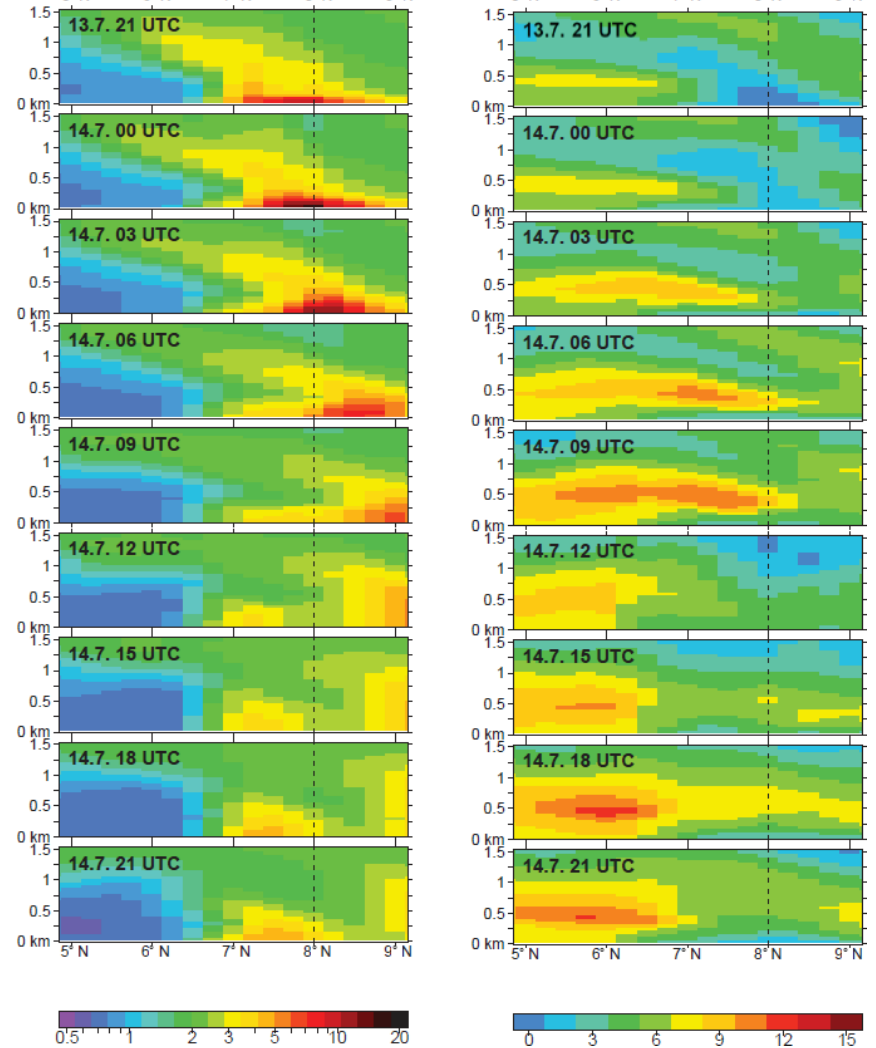
Figure 11. Vertical transect (kma.g.l.) from COSMO-ART of the total BC (µgm − 3 ; left) and wind speed (ms − 1 ; right) along the longitude of Savè between 21:00UTC on 13 July 2016 and 21:00UTC on 14 July 2016. The dashed line indicates the location of